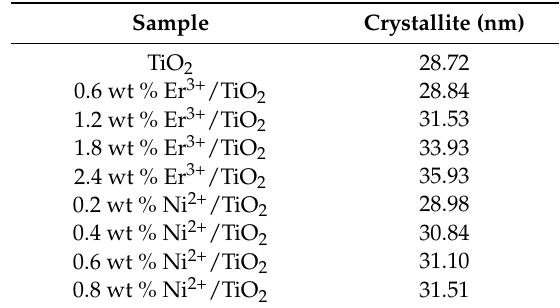
Table 3. Catalyst crystallite size of TiO 2 with several wt % of Er 3+ and Ni 2+